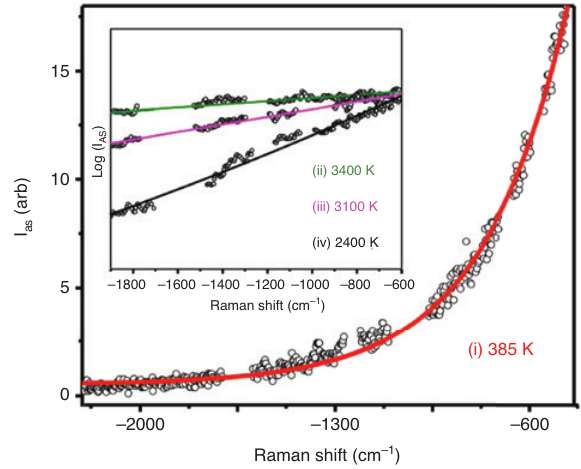
Figure 3: The temperature of the electron gas measured in the vicinity of a gold plamonic junction through electronic Raman scattering